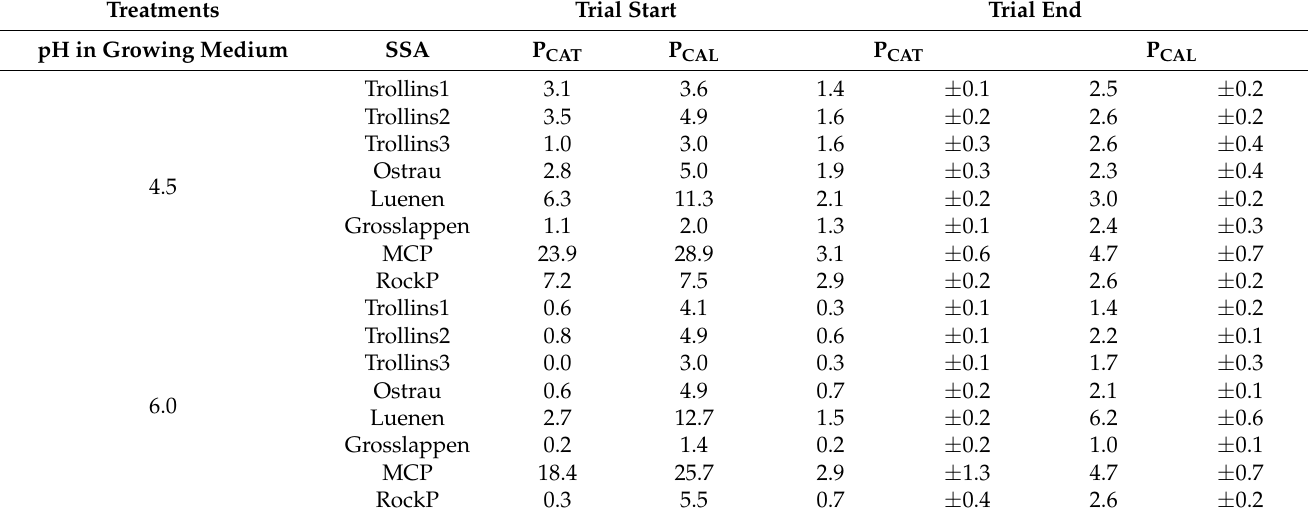
Table 4. CAT and CAL extractable amount of phosphorus (P CAT , P CAL ) in the growing media (mg pot − 1 ) of contrasting pH (4.5, 6.0) at the start and end of the trial, fertilized with sewage sludge ashes (Trollins1, Trollins2, Trollins3, Ostrau, Luenen, Grosslappen), water-soluble monocalcium phos- phate (MCP), and rock phosphate (RockP), respectively. Details of the sewage sludge ashes are sum- marized in Tables 1 and 2. Values at the end of the experiment are presented as the mean ± standard deviation (n = 4). Treatments Trial End